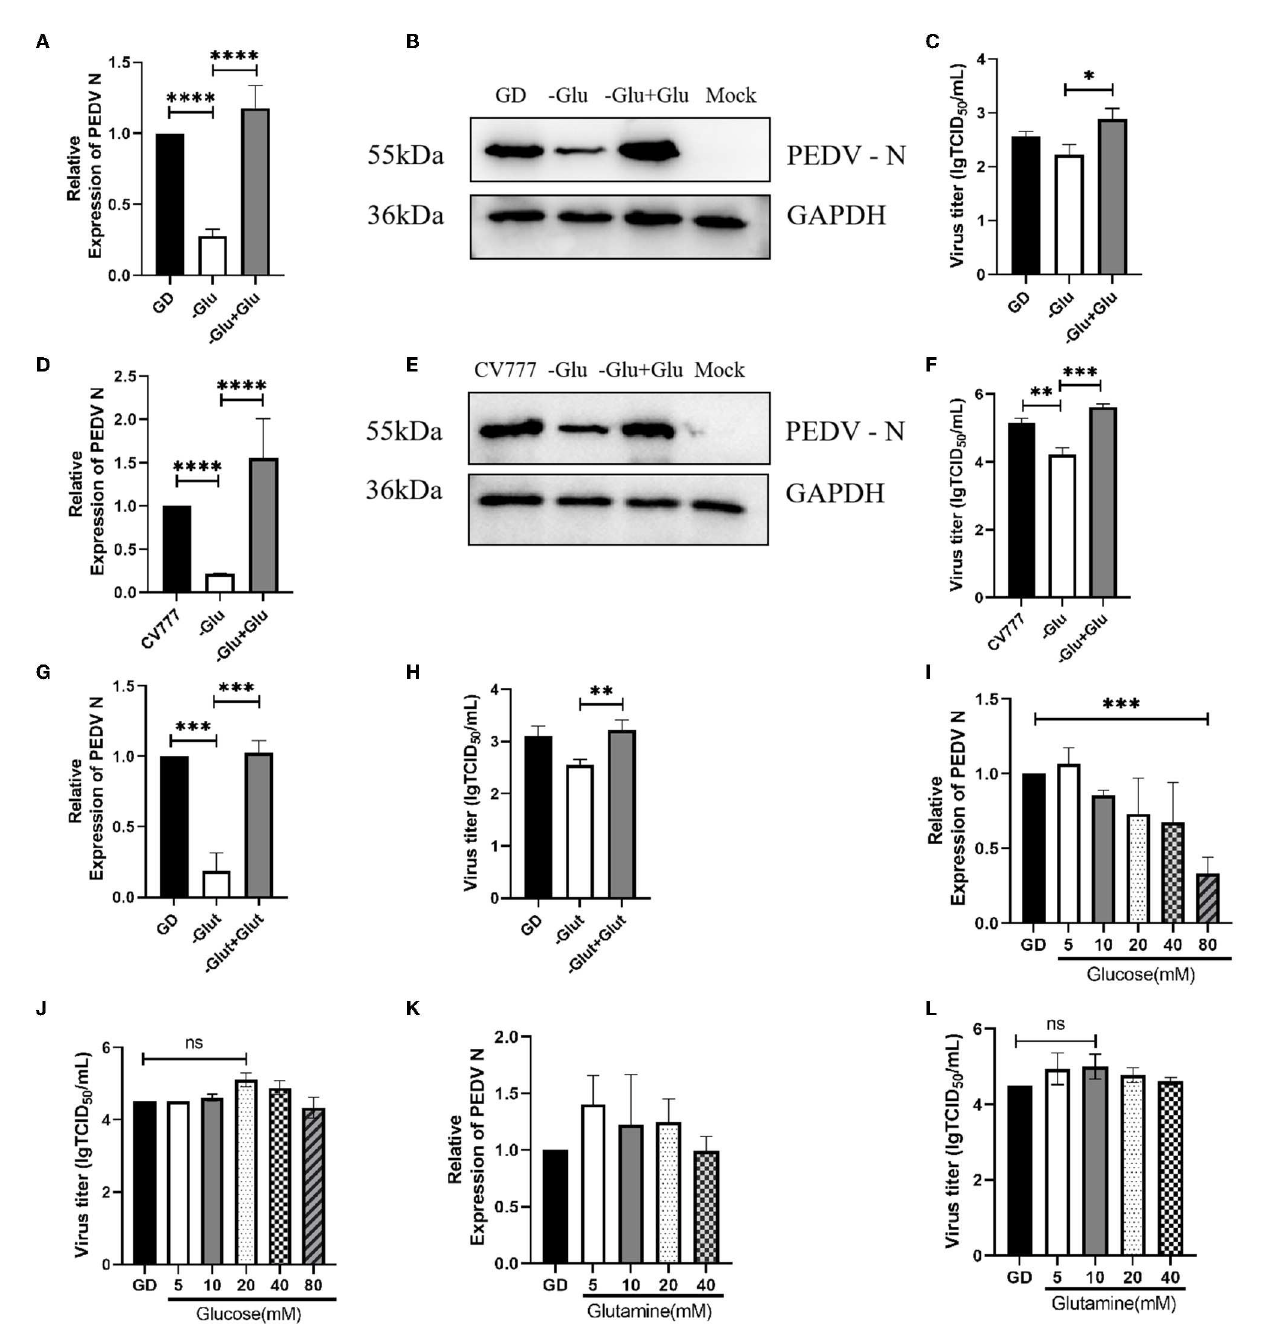
FIGURE1 The role of glucose and glutamine in PEDV replication. (A–C) Glucose starvation (-Glu) inhibited the replication of PEDV GD/HZ/2016 (GD) strain in Vero cells, as seen by the analysis of the mRNA levels (A) , protein levels (B), and viral titers (C) 24h post infection. * p < 0.05; ** p < 0.01; *** p < 0.001; **** p < 0.0001. (D–F) Glucose starvation also inhibited the replication of the PEDV CV777 strain in Vero cells, as shown by the analysis of PEDV N mRNA levels (D) , protein levels (E) , and virus titers (F) at 24h post infection. (G, H) RT-qPCR and TCID 50 analysis of the effect of glutamine starvation in culture medium (-Glut) and supplementation with 2mM glutamine (–Glut + Glut) on PEDV GD/HZ/2016 replication. (I, J) PEDV GD/HZ/2016N mRNA levels and viral titers after the addition of DMEM with 5, 10, 20, 40, and 80mM glucose. (K, L) PEDV GD/HZ/2016N mRNA levels and viral titers after the addition of DMEM with 5, 10, 20, and 40mM glutamine. The meaning of ns is “no significance” p >